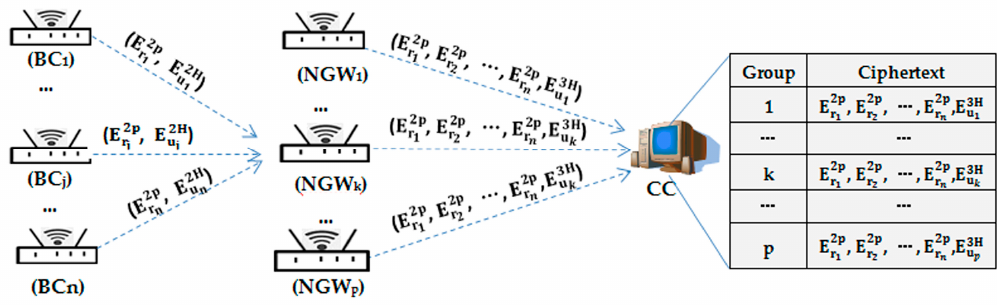
Figure 4. Message packet transmission process and storage.